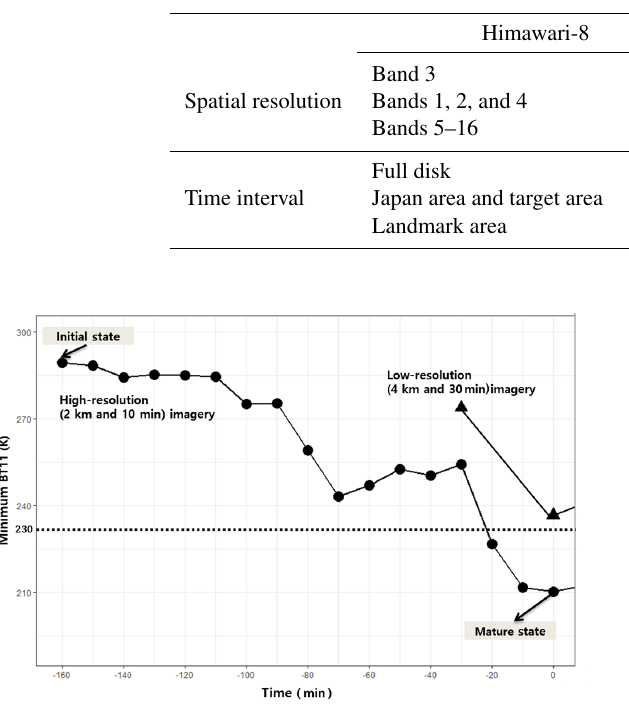
Figure 3. An example of temporal changes in the minimum BT11 among thunderstorm pixels (10 August 2017 at 03:10–05:50UTC) for the high-resolution (2km and 10min) imagery (circle) and the low-resolution (4km and 30min) imagery (triangle). In this study, the lead time was defined as the time between the initial state and the mature state (time 0). Negative time indicates the time ahead of the mature state of a tropical